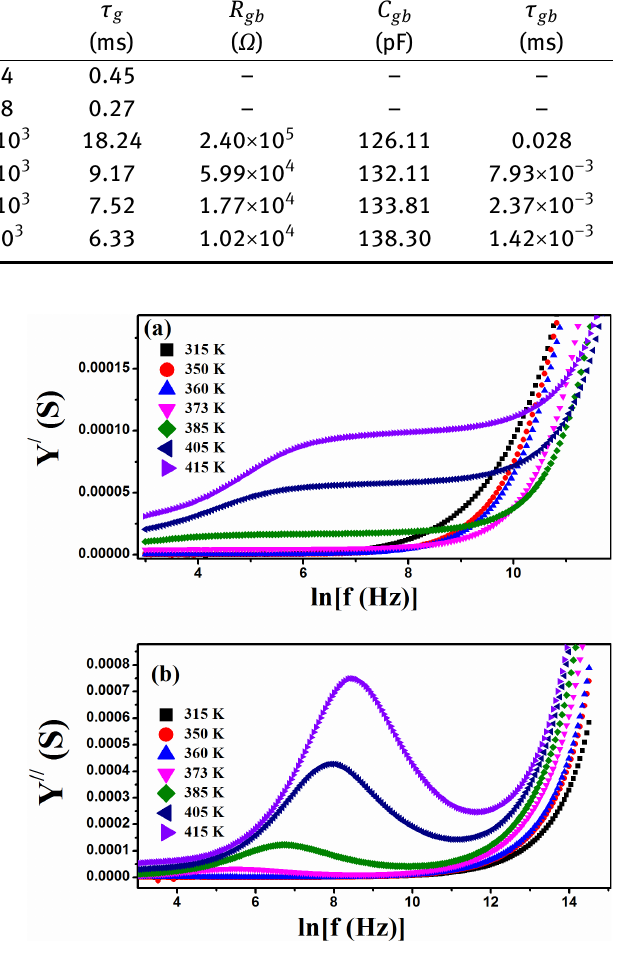
Figure 7: (a) The frequency dependence of real part ( Y ′ ) of Admit- tance of the sample at different temperatures, (b) Frequency de- pendence of imaginary part ( Y ′′ ) of Admittance of the sample at different